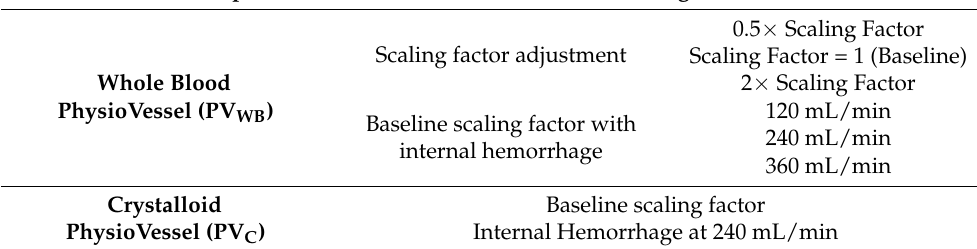
Table 1. Experimental Design for Evaluating the Adaptive Resuscitation Controller. Testing condi- tions for demonstrating the ARC capabilities using various hemorrhage rates and scaling factors, as well as evaluation with the whole blood and crystalloid PhysioVessel. Triplicate tests were performed at each